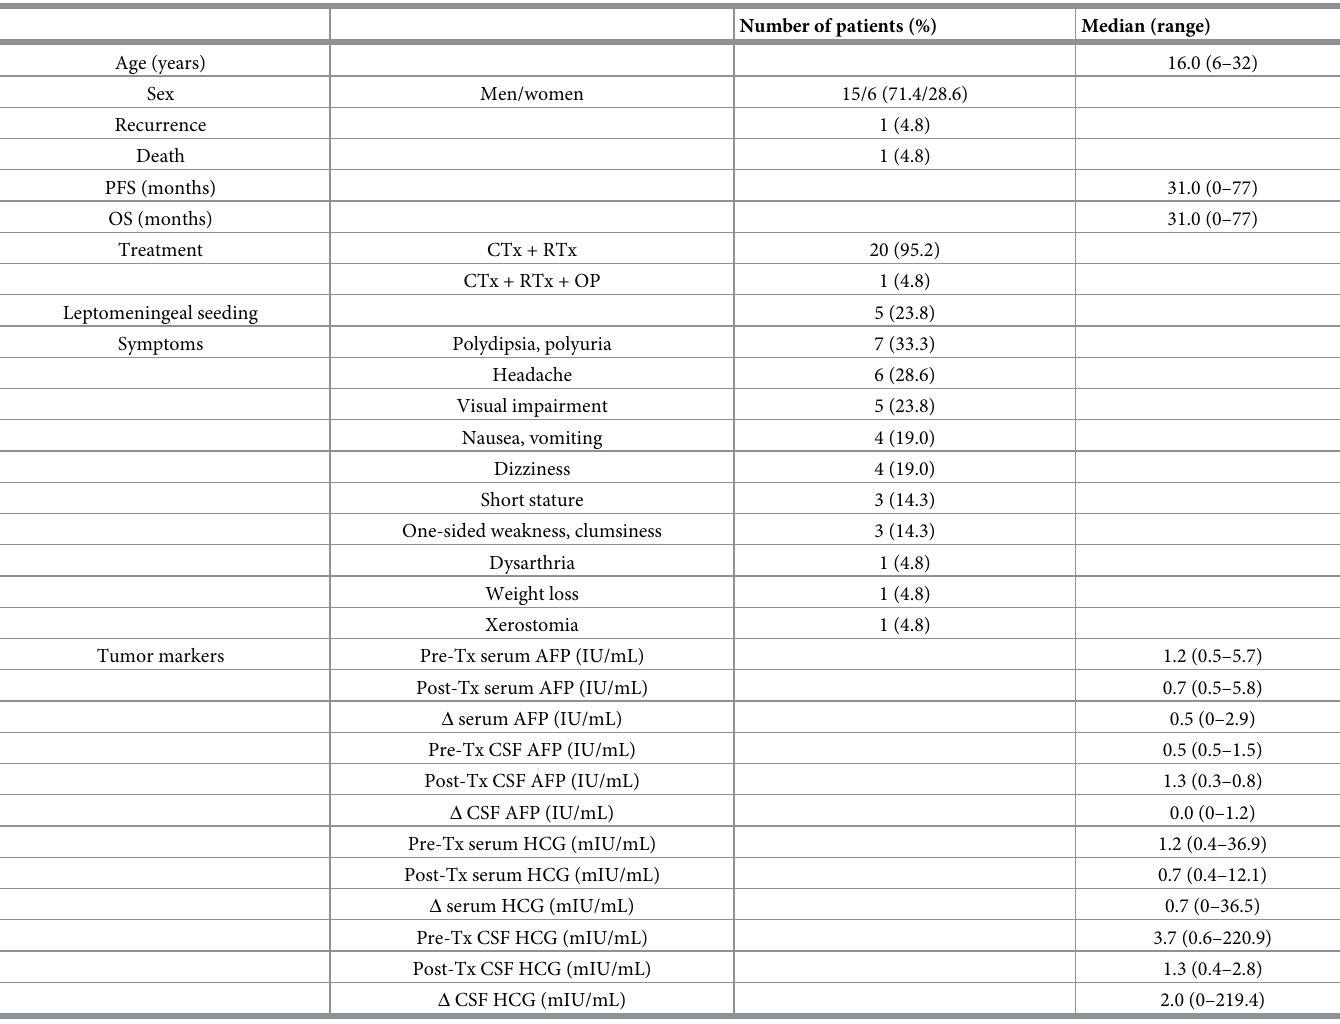
Table 1. Characteristics of 21 patients with